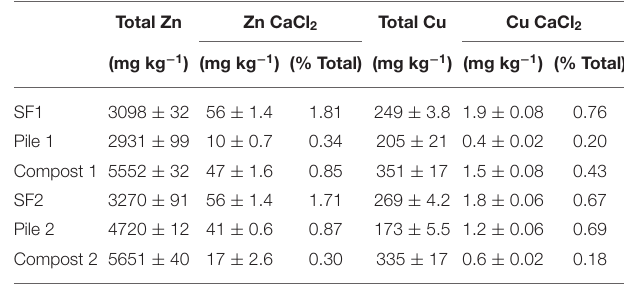
TABLE 2 | Total and 0.1M CaCl 2 -extractable metal concentrations in the solid fractions of pig slurry (SF1 and SF2), the initial composting mixtures (Pile 1 and Pile 2), and the mature composts (Compost 1 and Compost